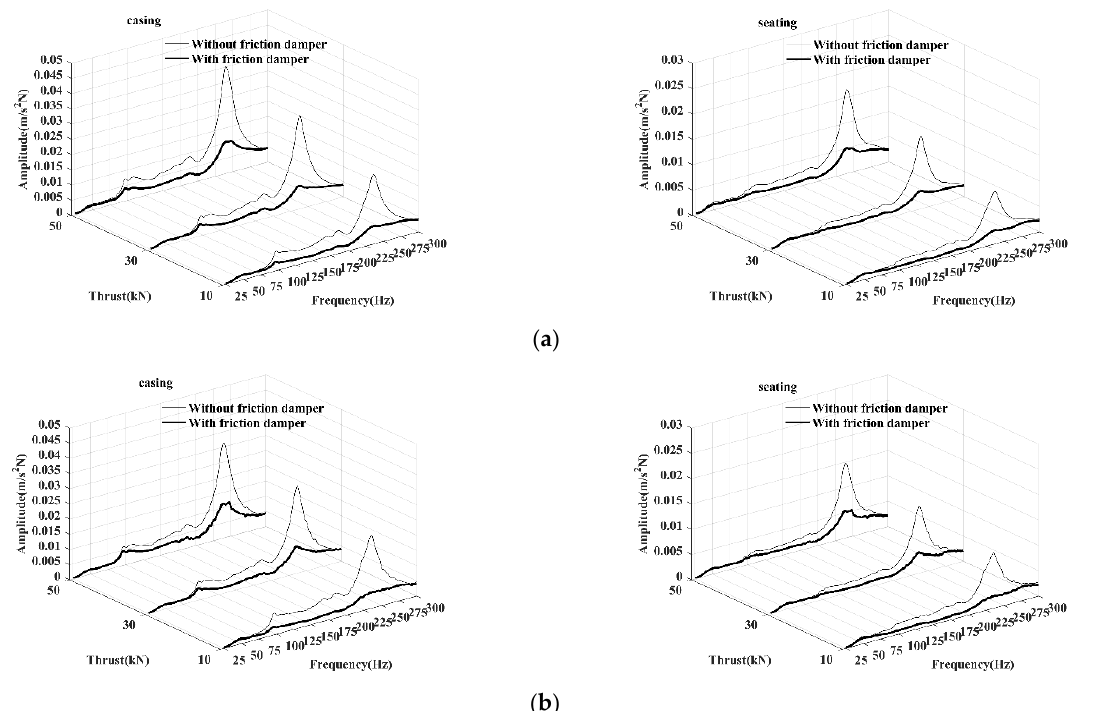
Figure 18. Comparisons of the AFRF of thrust bearing with and without friction damper at differ- ent rotational speeds: ( a ) rotational speed at 60 rpm; ( b ) rotational speed at 160